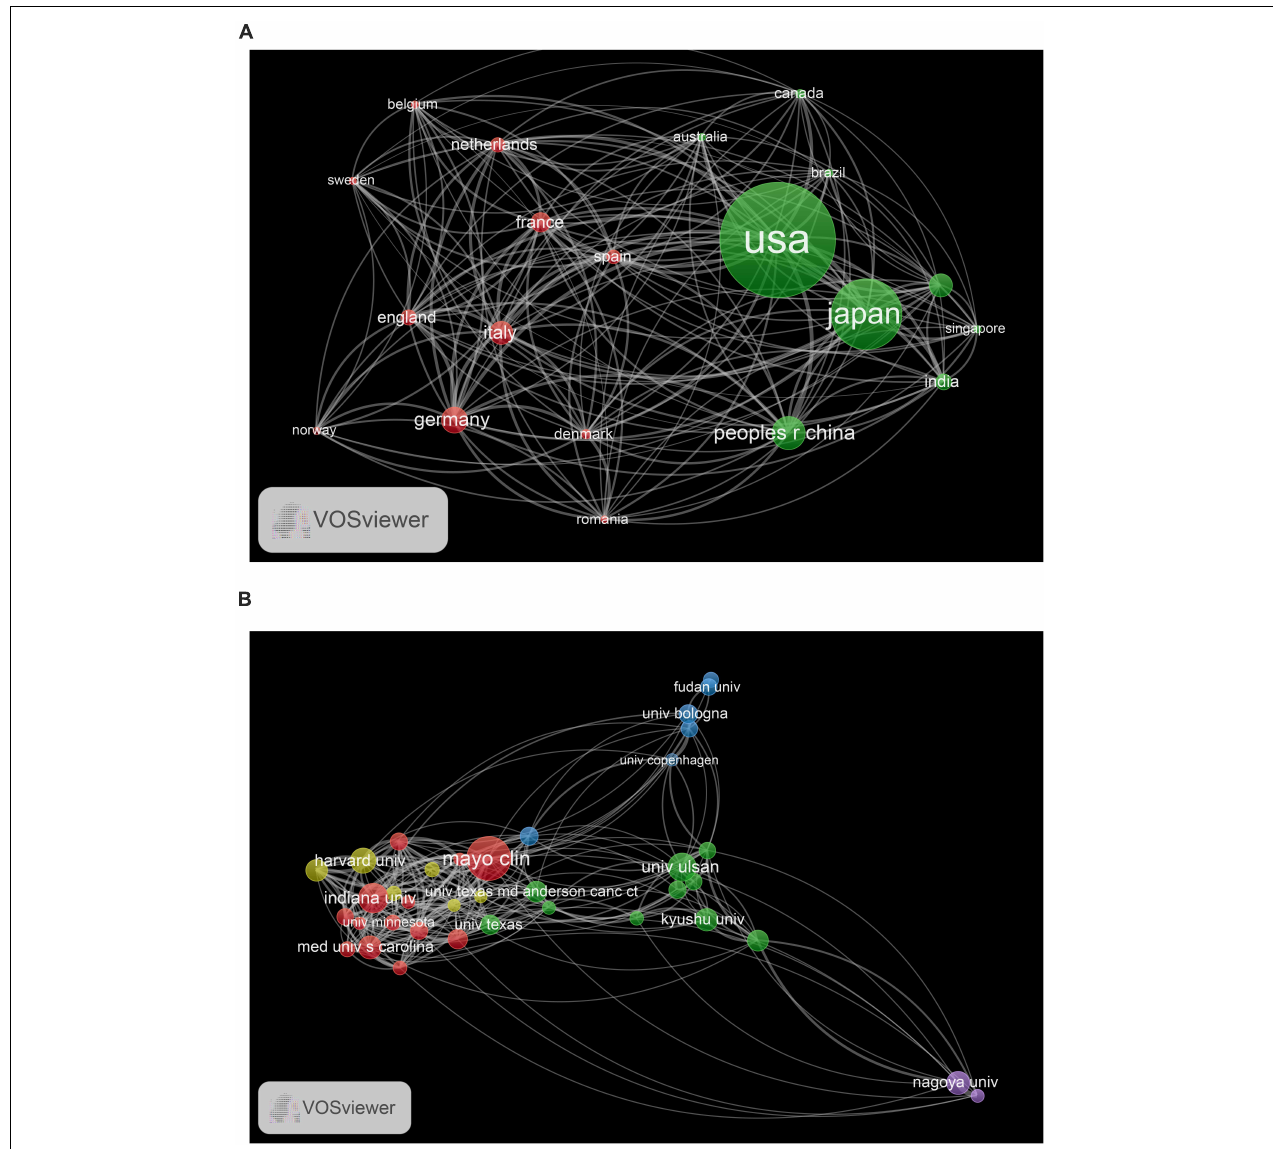
FIGURE 3 | (A) The network map of countries for EUS research. (B) The network map of institutions for EUS